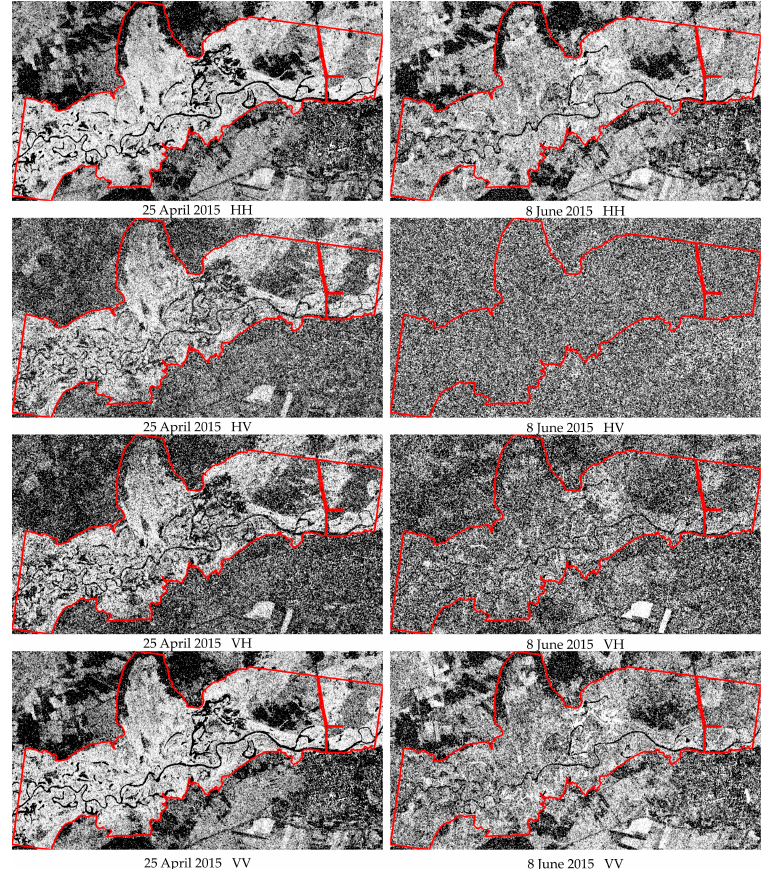
Figure 6. Examples of the TSX/TDX coherence images for two different acquisition dates and four polarizations.